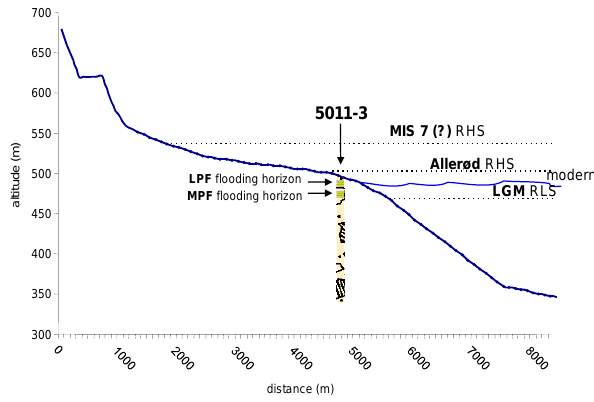
Fig. 10. Core position with respect to Quaternary lake level changes and interpreted flooding horizons. Altitudinal positions of the relative highstands (RHS) are based on Glushkova and Smirnov (2007). The position of the relative lowstand (RLS) is based on Juschus et al. (2011). LPF and MPF refer to interpreted lithological events (see also Fig. 7).